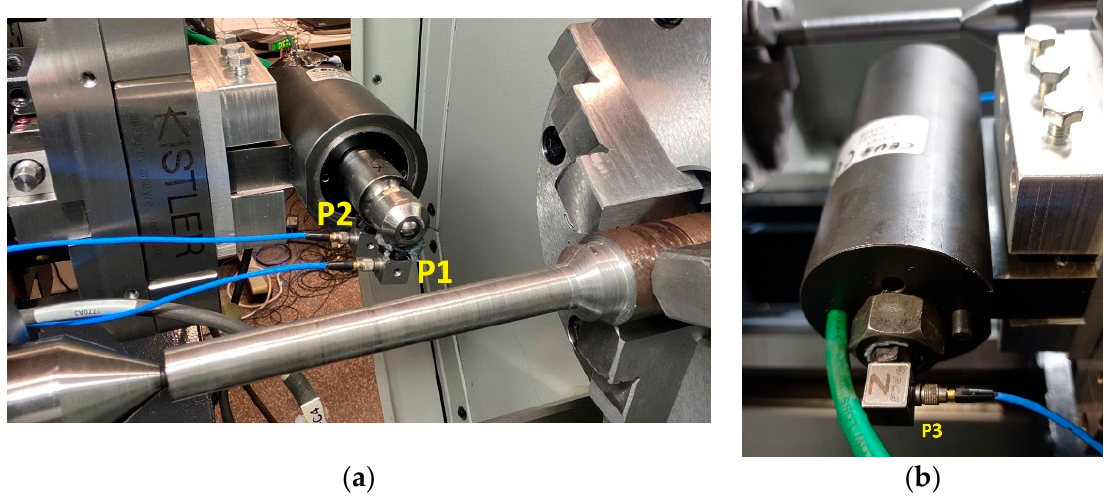
Table 1. Cutting parameters and specimen dimensions (initial and final).